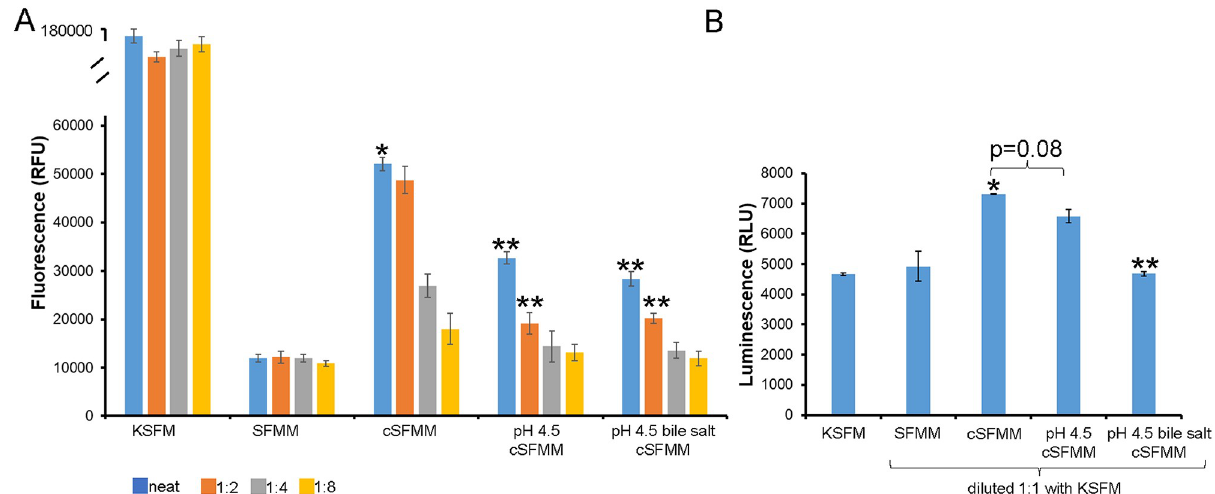
Fig 5. Esophageal epithelial basal cell proliferation in response to untreated and acid and acidic bile salt treated HEMF conditioned media. (A) Fluorescence proliferation assay. Epithelial cells (STR, 600 cells/well of 96 well plate) were treated with conditioned media of untreated HEMFs (cSFMM) or conditioned media from pH 4.5 and pH 4.5 bile salt treated HEMFs, at 1:1, 1:2, 1:4; and 1:8 dilutions in SFMM for 48 hrs. Controls were undiluted keratinocyte serum-free media (KSFM, ThermoFisher Scientific) and serum-free, EGF-free myofibroblast media (SFMM). � p < 0.05 vs. cSFMM. Proliferation was assessed with alamarBlue assay. (B) Luminescence proliferation assay. STR were plated overnight (2000 cells/well of 96 well plate) and then cultured for 96 hours with KSFM, or with SFMM, cSFMM, or conditioned media from HEMFs treated with pH 4.5 or pH 4.5 bile salts, all diluted 1:1 in KSFM, as described in the methods. On day 4, CellTiter-Glo assay reagents was added per manufacturer’s instructions and luminescence read. � p < 0.05 vs. KSFM and SFMM; �� p < 0.05 vs cSFMM. In panel A, �� is p < 0.05 vs cSFMM for the indicated dilution.